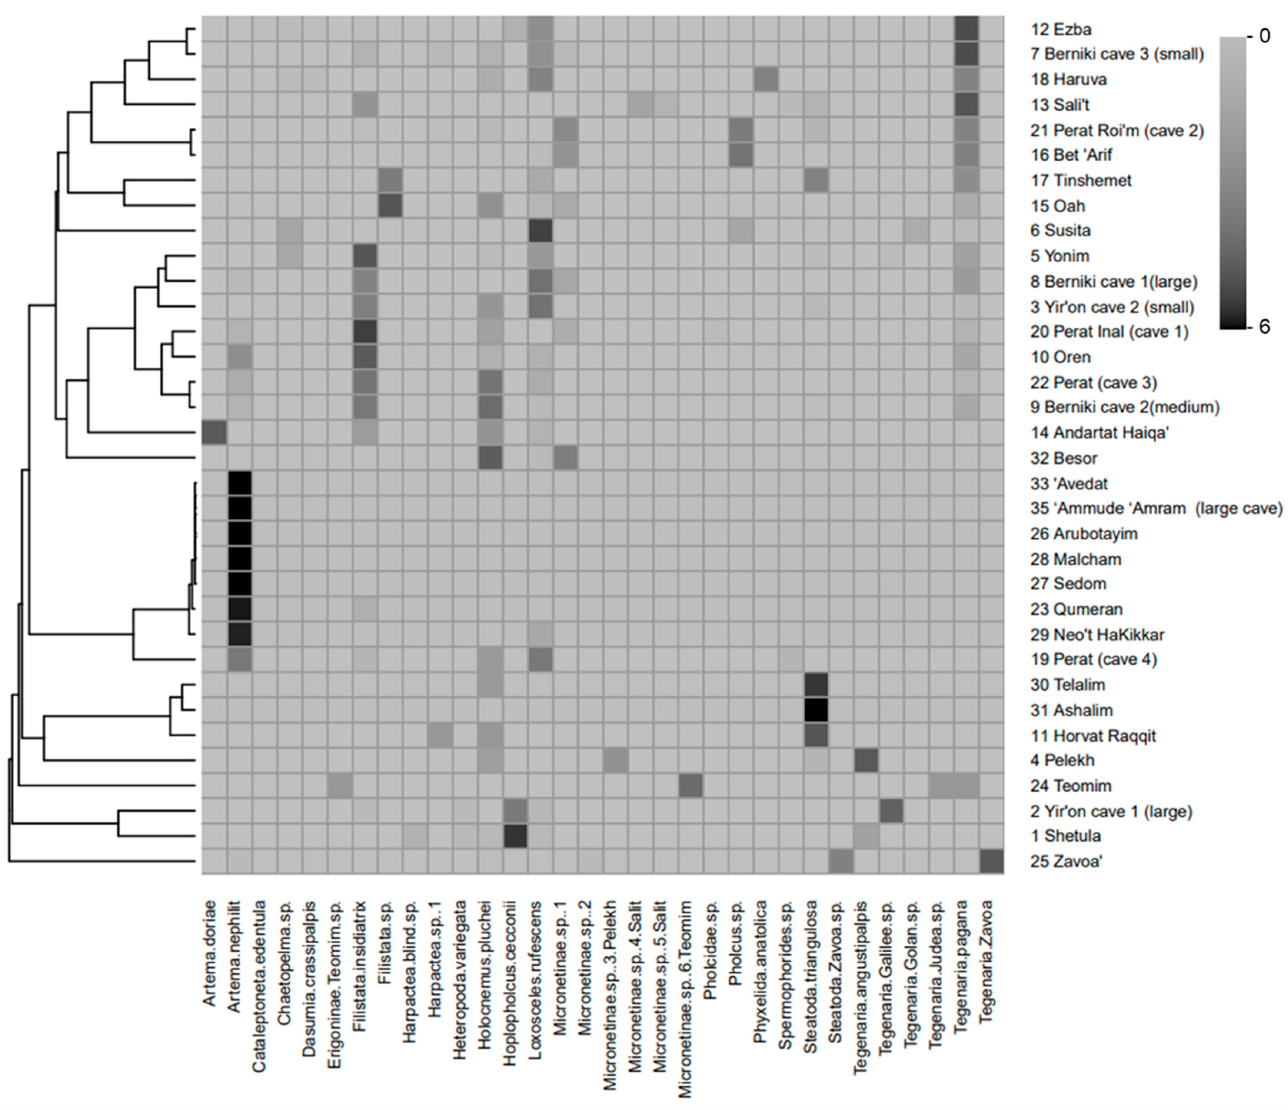
Figure 10. Cluster heatmap for 34 caves (rows) and 32 troglobite and troglophile species (columns) (‘Ammude’ Amram (cave 34) had no observed spiders during our two visits). Caves are clustered using hierarchical clustering from pairwise Pearson correlation. Darker colors signify higher correlation. Numbers before cave names as in Figure 1 and Appendix A.